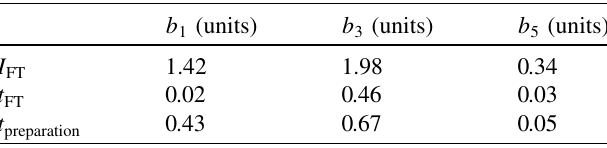
TABLE IV. The effect of each powering history parameter on the allowed harmonics.